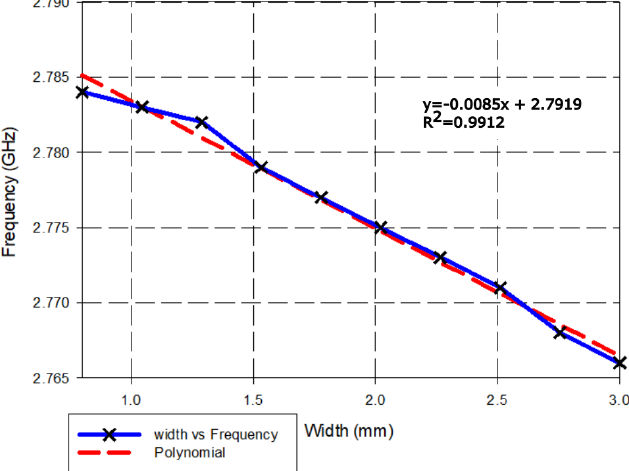
Figure 5. Graph of the width of square ring resonator, Wsq against resonance frequency and regression plot.